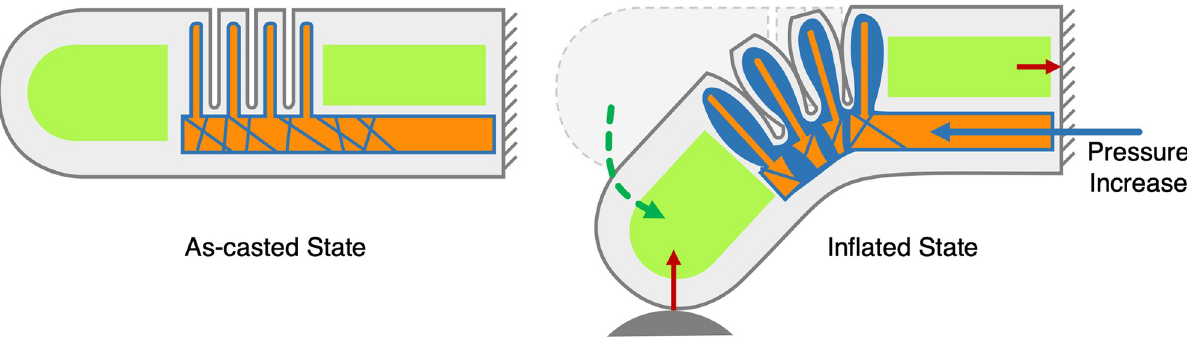
Fig 13. Main actuation principle of the soft robotic finger. As the actuation fluid (air/water) increases in pressure or volume, the fluid travels along the cavity left by the negshell core up to the fins of the bellows and start to expand the thin walls of the silicone elastomer surrounding the fins which creates a bending